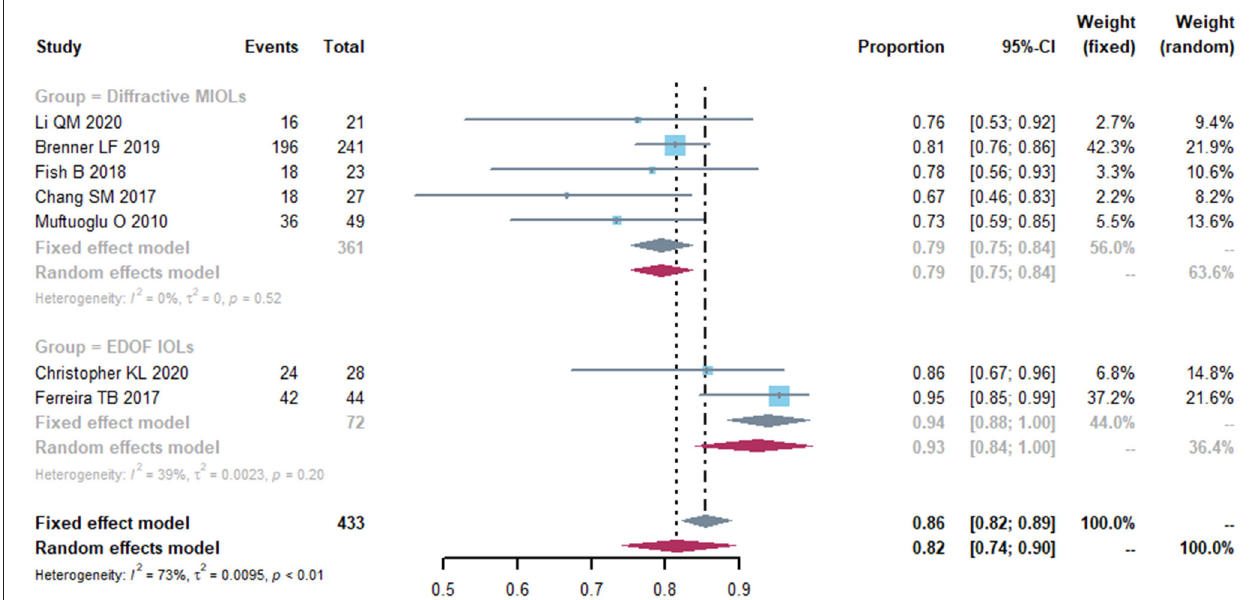
FIGURE 2 | Forest plot of uncorrected distance visual acuity (UDVA). The proportion of the eyes with a postoperative visual acuity ≥ 20/25 was represented in this graph. Events, number of treated eyes with a postoperative visual acuity ≥ 20/25. Total, total number of treated eyes. Proportion, proportion of eyes ≥ 20/25. CI, confidence interval; IOL, intraocular lense; MIOLs, multifocal intraocular lenses; EDOF, extended depth-of-focus.